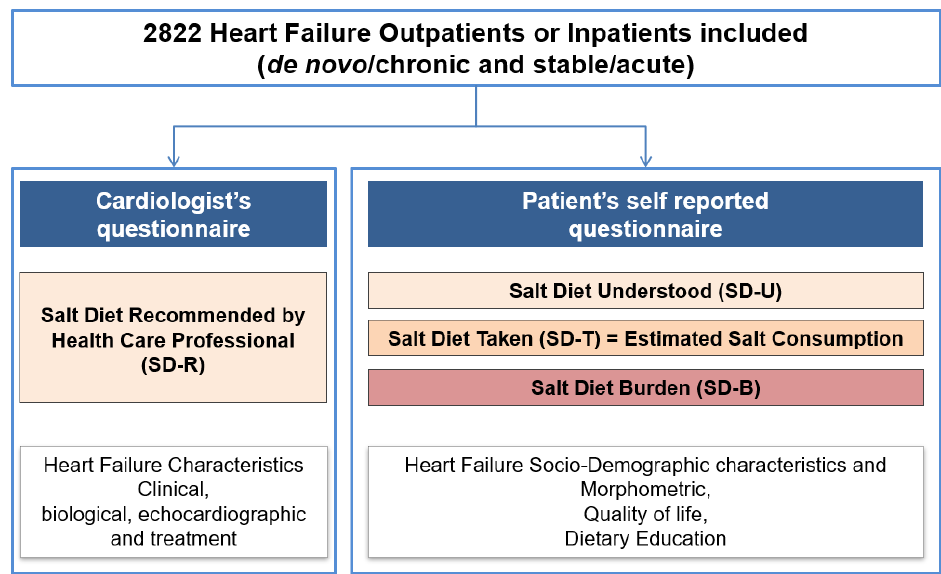
Figure 1. Study design.